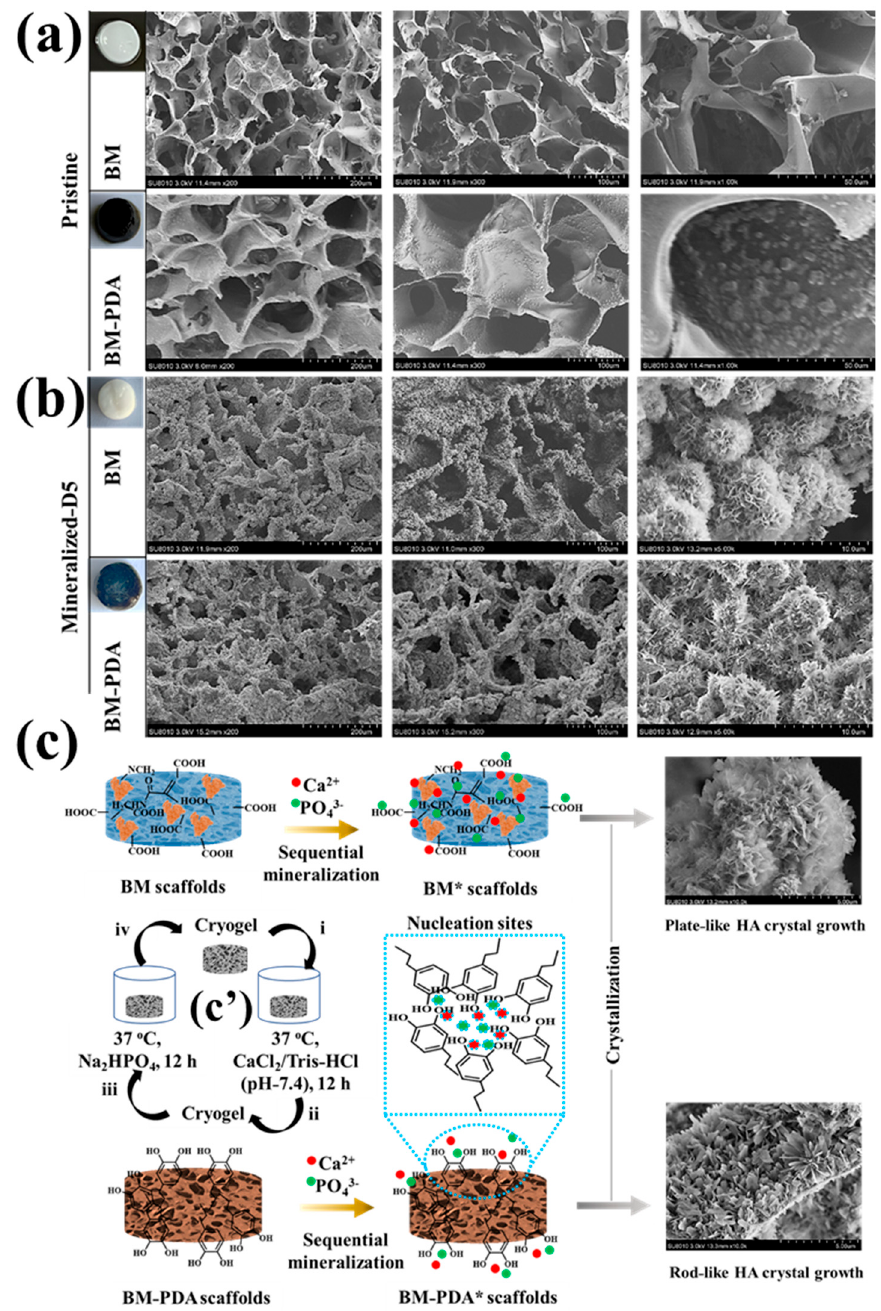
Figure 3. SEM cross-sectional descriptions of ( a ) pristine BM and BM-PDA, and ( b )mineralized BM* and BM-PDA*. Insets in a and b represent the gross appearance of the as-prepared, functionalized, and mineralized cryogels. ( c ) Proposed mechanisms of the plate- and rod-like morphology of the mineralized scaffolds, respectively with c’ depicting the process of sequential mineralization (i-iv represents one cycle or one day treatment, consisting of a 12-h incubation in the CaCl 2 solution, followed by a 12-h incubation in the Na 2 HPO 4 solution, and a final 12-h rinse in deionized water).